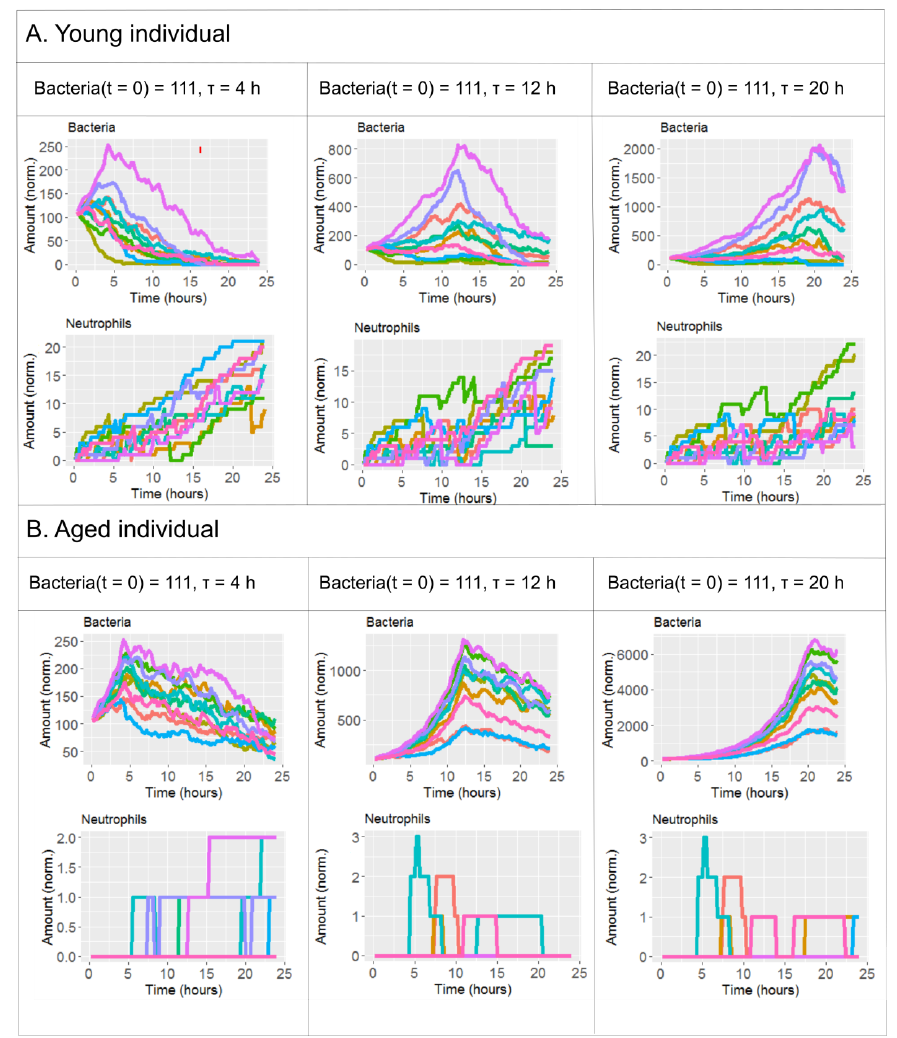
Figure 3. ( A ) Simulations of four di ff erent conditions modifying the antibiotic time regimen ( τ ) for young individuals. ( B ) Simulations of four di ff erent conditions modifying the antibiotic time regimen (τ) for aged individuals. Additional variables are shown in Figure S1.